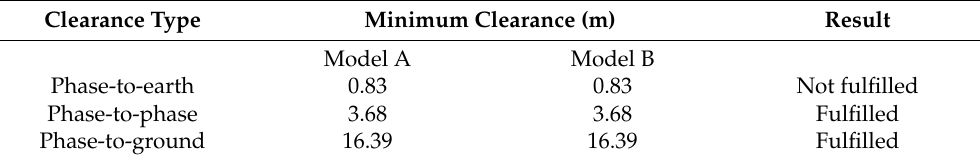
Figure 5. The proposed model of the existing 132 kV transmission line by adjusting the crossarm length and its position; ( a ) Model A—midsection crossarm, and ( b ) Model B—top and bottom section crossarm. Table 6. Minimum electrical clearance by adjusting the crossarm length and its position.